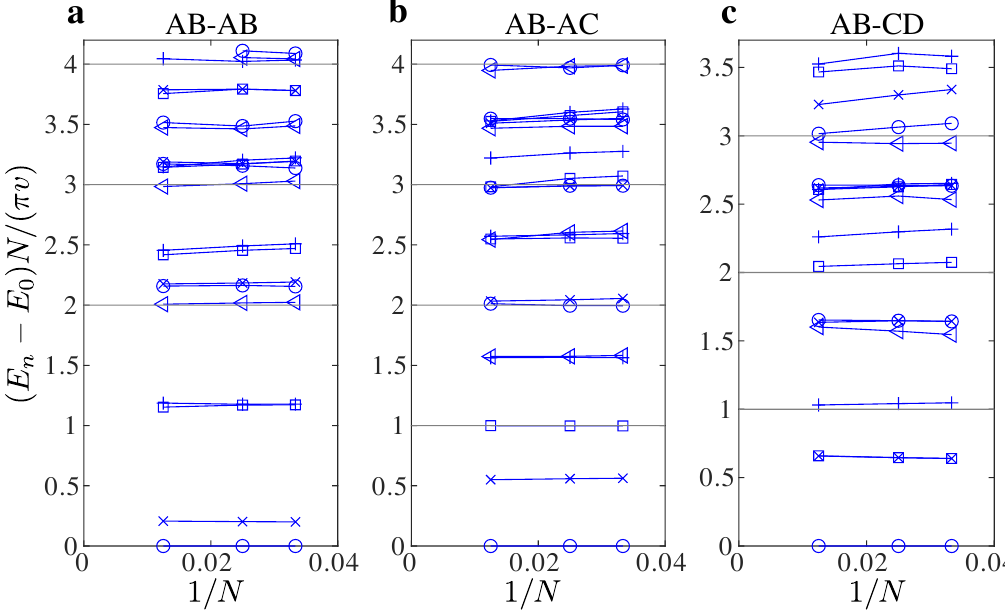
Figure 7: Conformal towers of states of the four-state Potts model with two-state mixed boundary condition. Symbols are DMRG data points extracted from the low- lying energy excitation spectra with velocity v = π/ 4. Gray lines are integer levels shown for